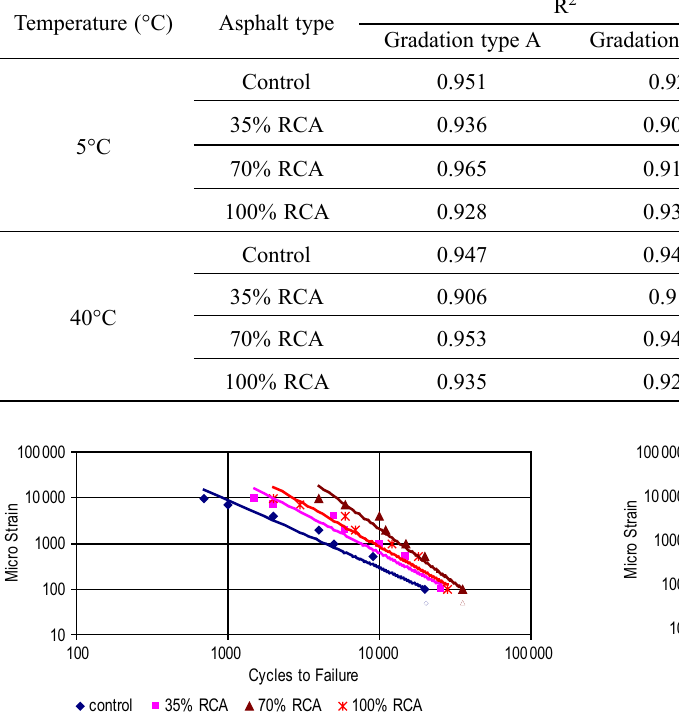
Fig. 6. Comparison of fatigue behavior of different mixes at 5 °C for gradation type B